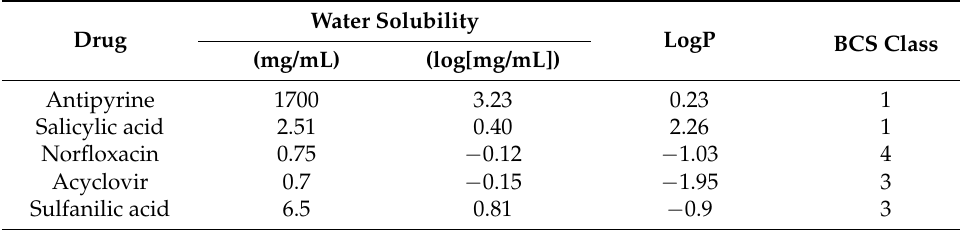
Table 1. Physicochemical properties of model drugs.